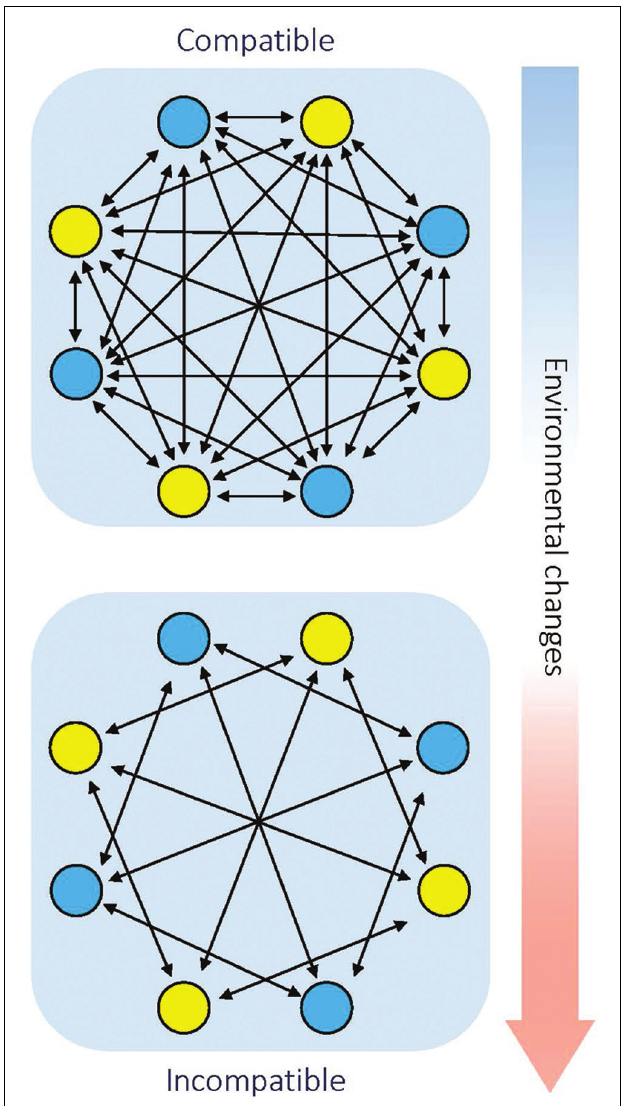
FIGURE 3 | Diagram of how environmentally conditioned hybrid incompatibility contributes to sympatric speciation. Arrows indicate gene flow between individuals. Blue and yellow dots indicate individuals with different genotypes that inhabit the same region. Initially, individuals with different genotype are compatible with each other. Along with environmental changes (such as decreasing temperature), environmentally conditioned genetic incompatibility leads to hybrid incompatibility between different